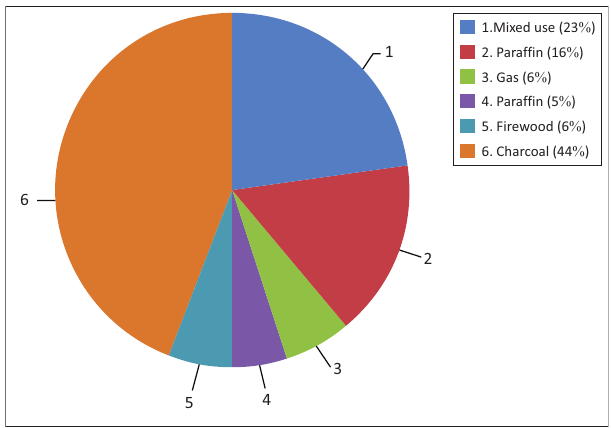
FIGURE 5: Energy sources in Mchikichini.